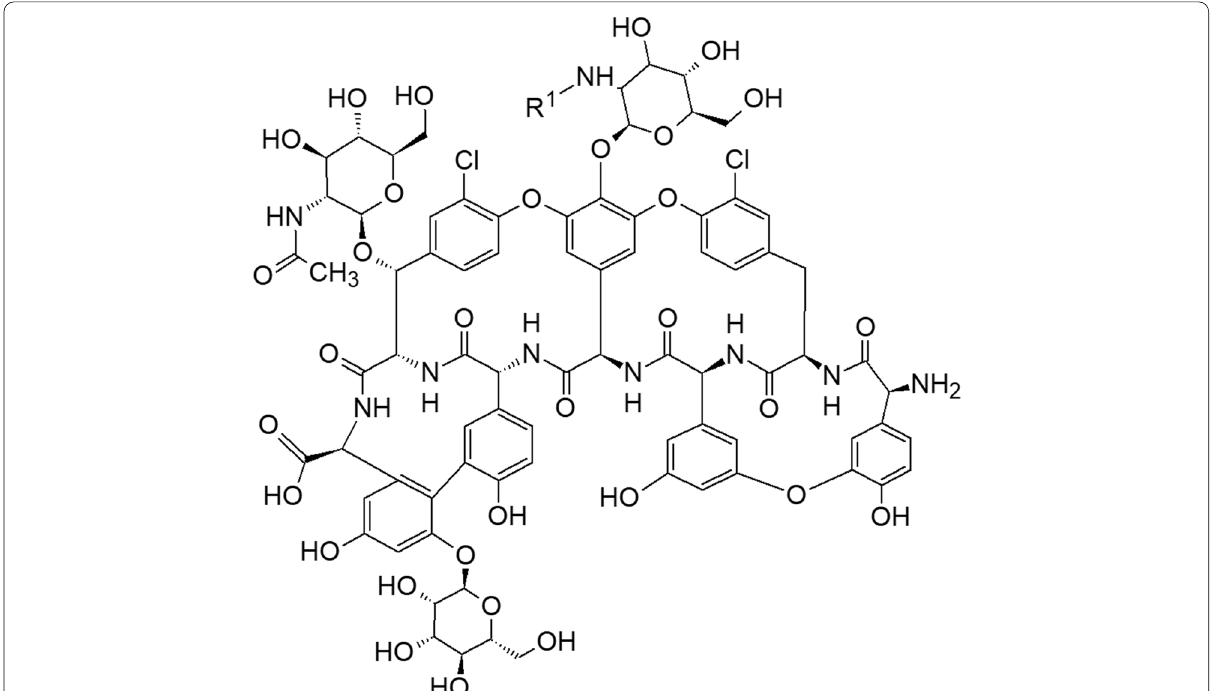
Fig. 7 Structural formula of teicoplanin. The structures of the R group for the different major homologs of teicoplanin are given in Table 2